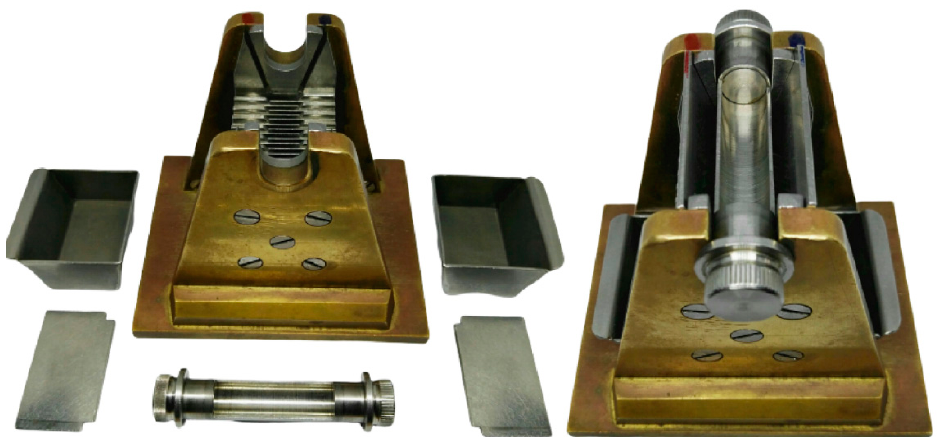
Figure 3. Riffle box designed to split sediments (length 10 cm, width 8 cm, and height 8 cm). Figure 3. Ri ffl e box designed to split sediments (length 10 cm, width 8 cm, and height 8